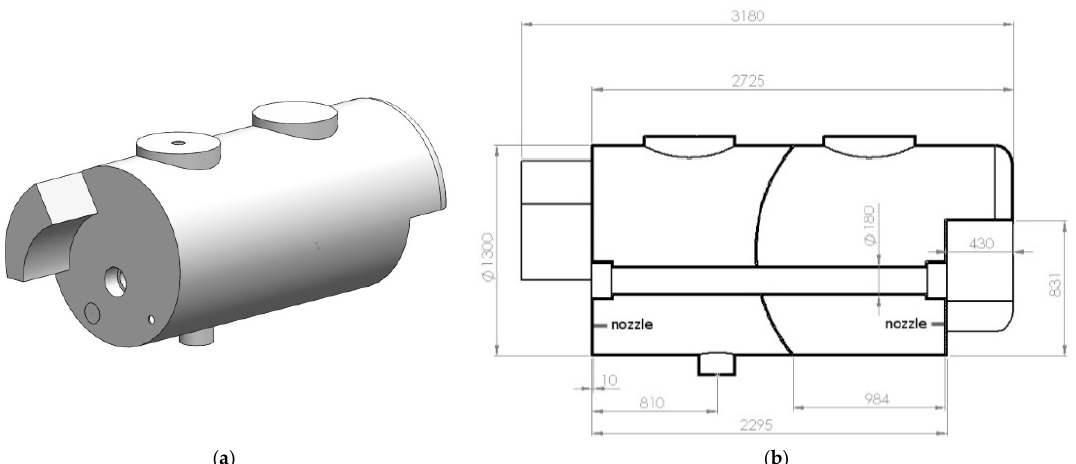
Figure 1. Geometry of the sprayer tank with a 3000 L capacity. ( a ) Exterior 3D view; ( b ) longitudinal interior 2D view. Dimensions in millimeters.